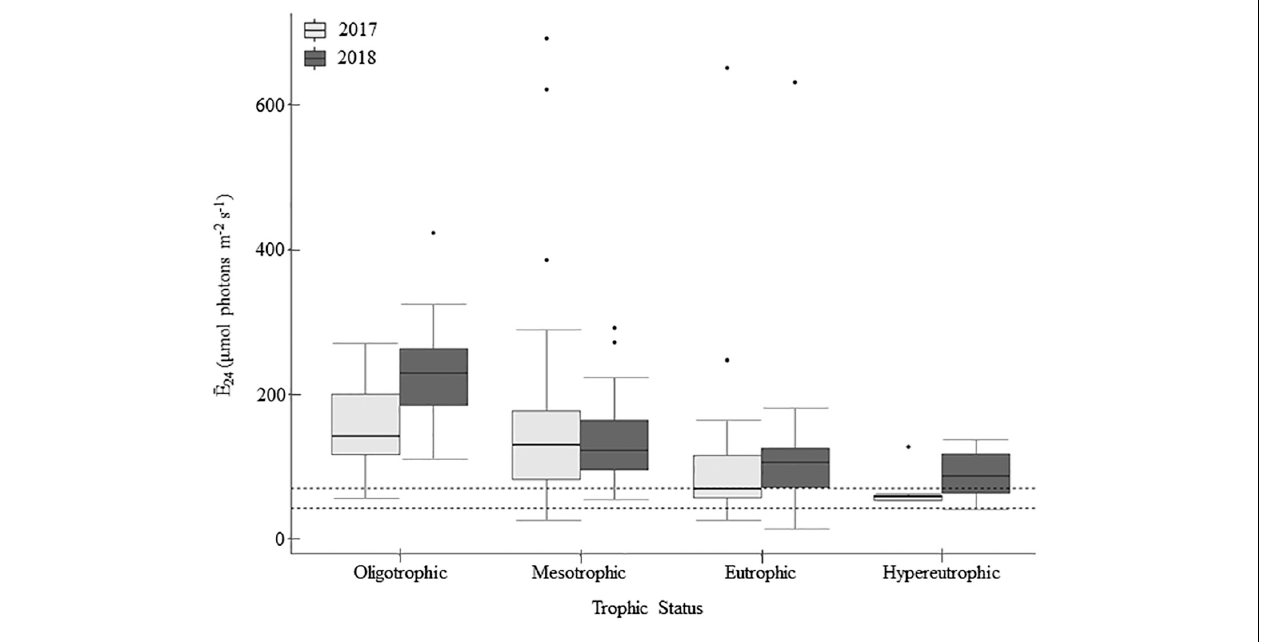
detection limit is denoted by an asterisk (*); detection limits are 0.03 µ mol L − 1 for TDP; for 2.50 µ mol L − 1 TDN; 0.36 µ mol L − 1 for NO 3 − ; and 0.71 µ mol L − 1 for NH 4 + . Numbers in superscript indicate n values that differed from those reported in the column headers. See Table 1 for parameter definitions, abbreviations, and units.